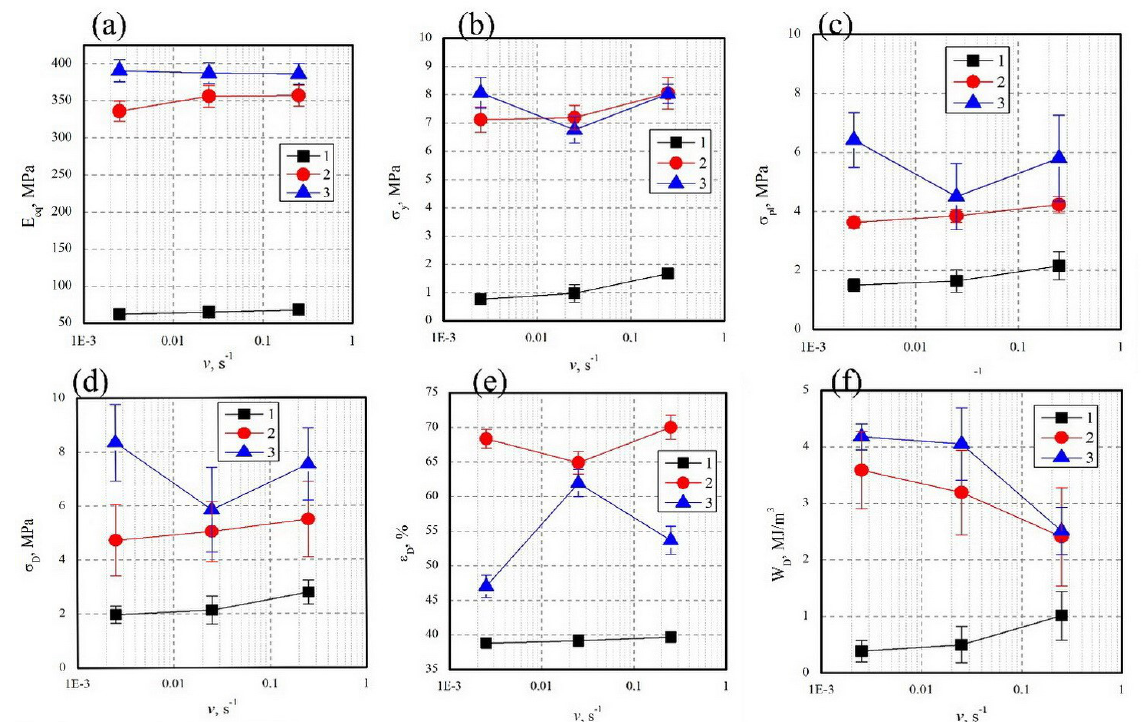
Figure 6: The mechanical properties (E qe , σ y , σ pl , σ D , ε D , W D ) of unreinforced (type 1), transverse reinforced (type 2), and longitudinal reinforced (type 3) foam samples for different strain